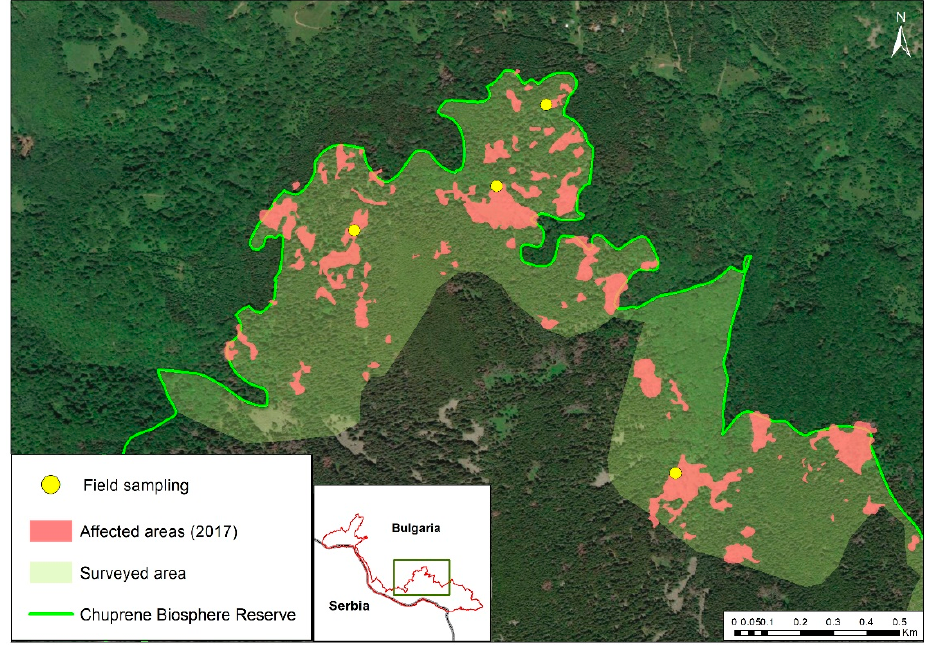
Figure 4. Studied Ips typographus spots in Chuprene Reserve.